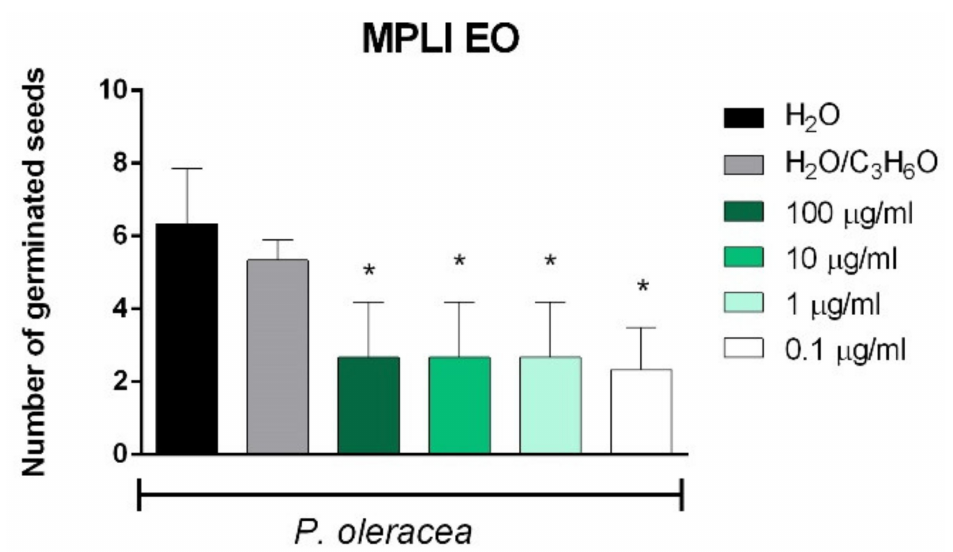
Figure 7. Phytotoxic activity of M. pulegium flowers (II) EO against the radical elongation of L. sativa (A) and germination of R. sativus (B) 120 h after sowing. Results are the mean of three experiments ± standard deviation. * p < 0.05compared with control (ANOVA followed by Dunnett’s multiple comparison test).